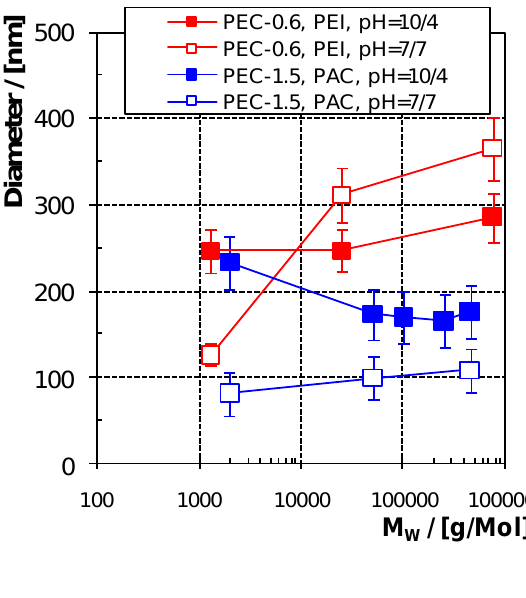
Figure 12. Plot of D c = 0.001 M (all) and n PEL